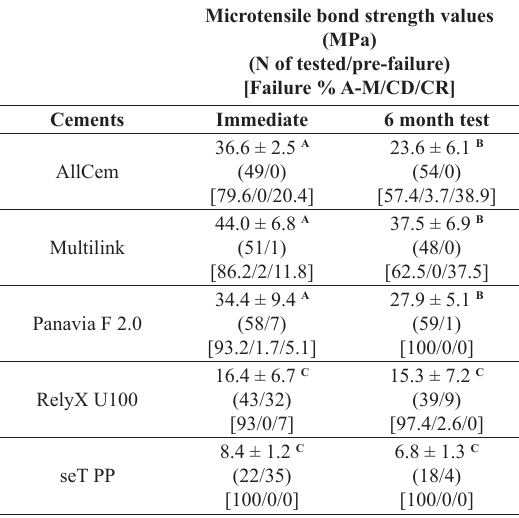
Table 2 – Mean and standard deviation of microtensile bond strength values (MPa) obtained for the different cements. Total number of beams (N tested stick/pre-load failure) and percentage distribution of failure mode after microtensile bond strength testing [Failure % Adhesive-Mixed / Cohesive Dentin / Cohesive